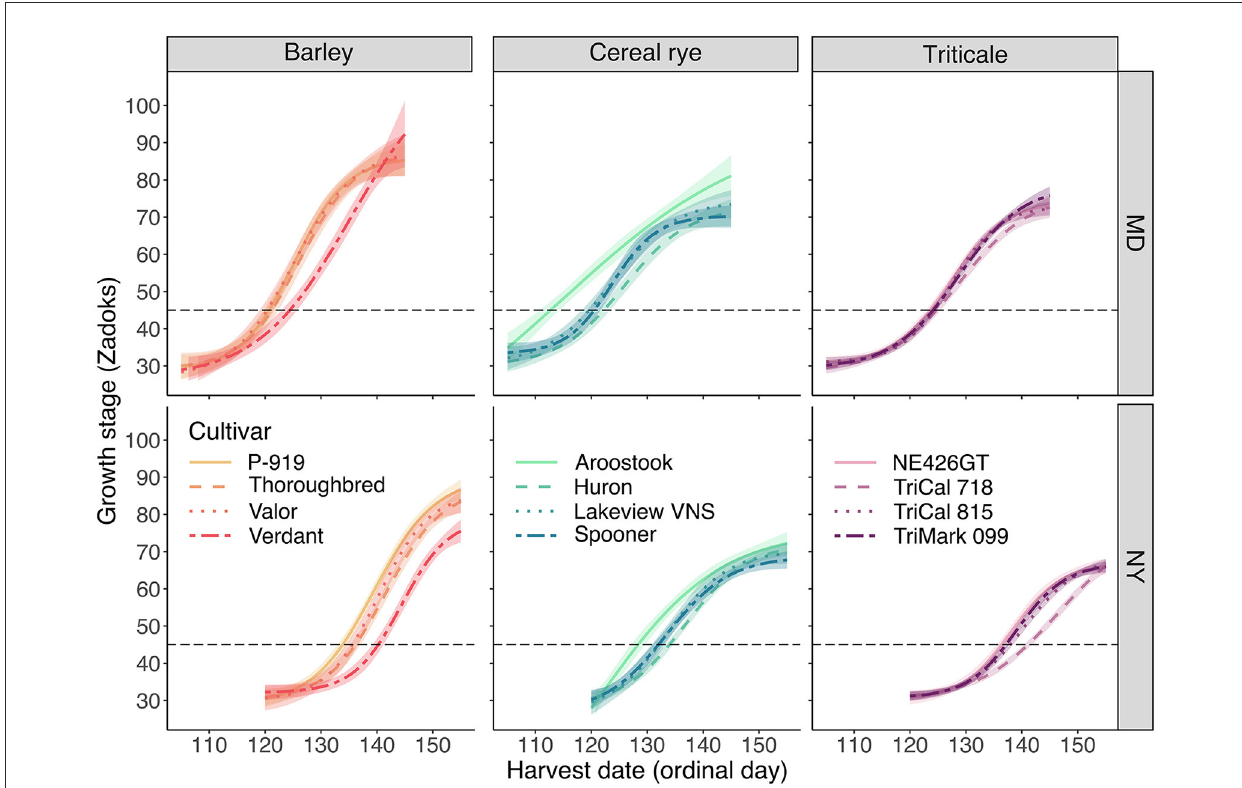
FIGURE4 Phenological development for barley, cereal rye, and triticale cultivars as described by the logistic models for the relationship between growth stage (Zadoks) and harvest date (ordinal day) in MD and NY. The shaded “ribbon” for each sigmoidal curve represents a 95% confidence interval. The horizontal dashed line indicates a common phenology-based harvest timing, swollen boot stage (Zadoks 45), for winter cereals grown for